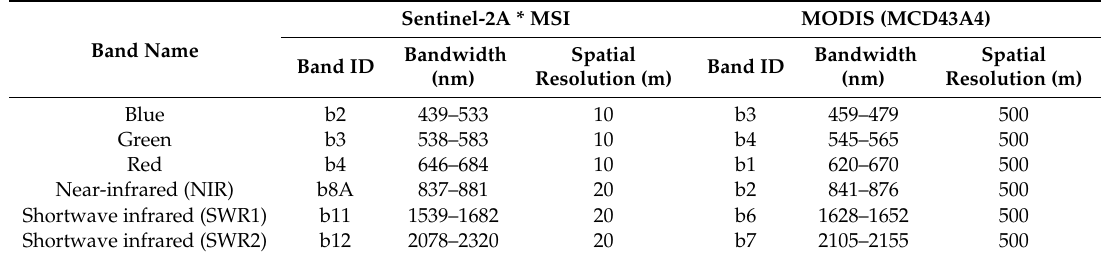
Table 1. Sentinel-2A MSI bands and the corresponding MODIS (MCD43A4) bands for image